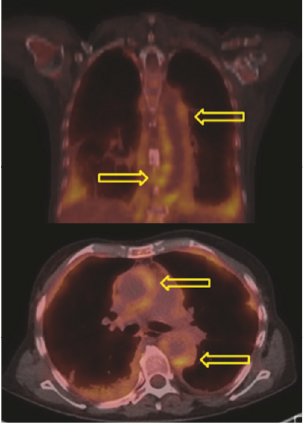
Figure 2: Chest CT with IV contrast showing soft tissue density surrounding the entirety of the thoracic and abdominal aorta (arrows), consistent with large-vessel